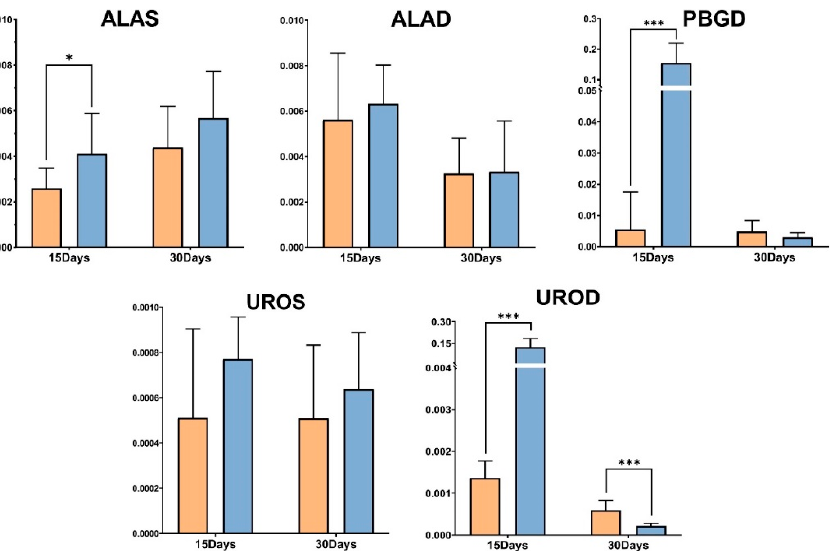
Figure 5. Quantitation of gene expression levels after RNAi treatment in C. gigas . Levels of respective gene transcripts relative to EfI transcripts analyzed by qPCR and expressed as the number of copies of interest gene per copy of EfI in the mantle of oysters at the end of interference day 15 and day 30 phases, expressed in fold change. The orange bars represent the gene expression level of the RNAi group and the blue bar represents the gene expression level of the EGFP group. The p values from a t -test demonstrate * p < 0.05 and *** p < 0.0005.